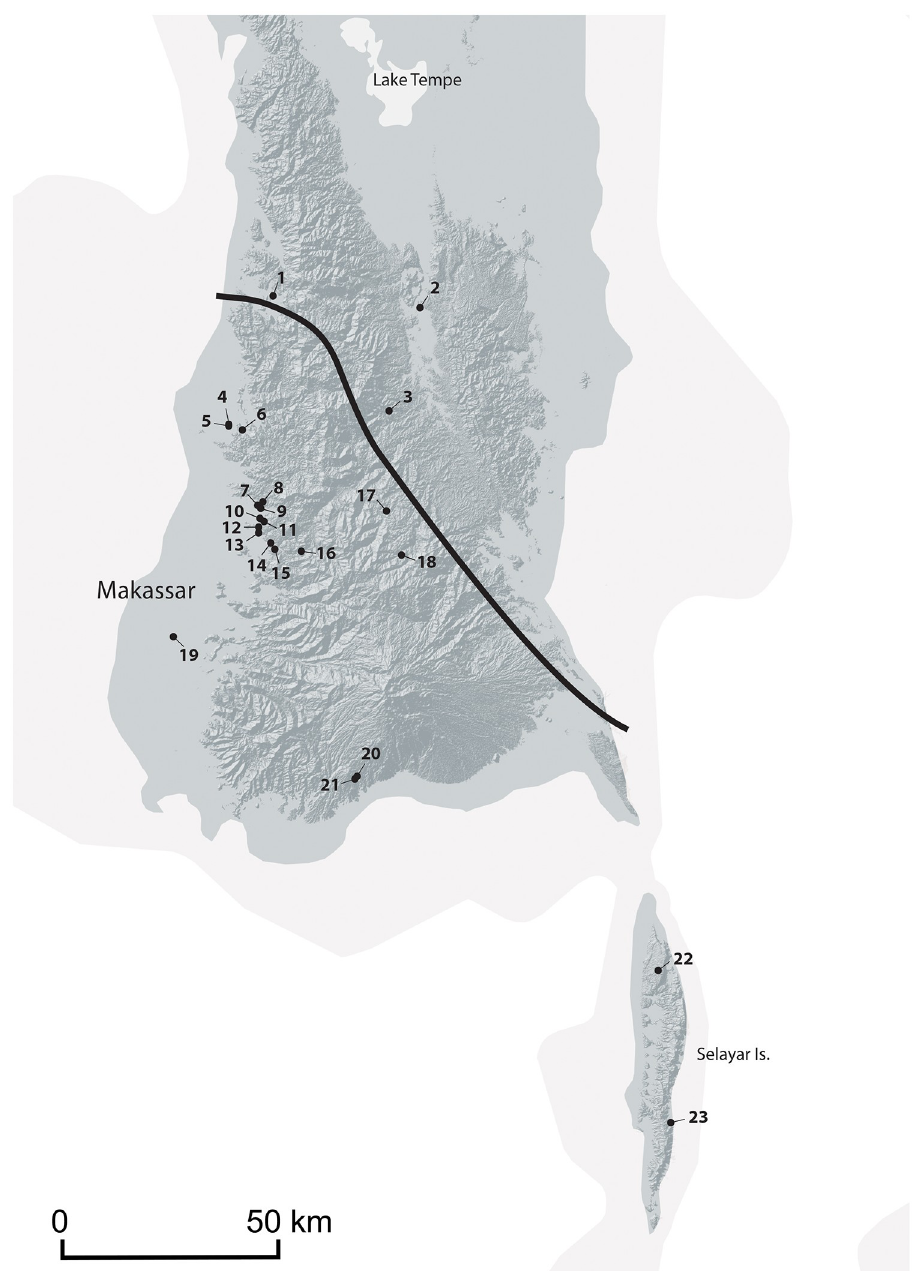
Fig 1. Map of South Sulawesi, Indonesia, showing sites mentioned in the text. 1 . Ralla, 2 . Mallinrung, 3 . Leang Panninge, 4 . Leang Bulu’ Sipong 4, 5 . Leang Bulu’ Sipong 1, 6 . Leang Sakapao, 7 . Leang Rakkoe, 8 . Leang Lompoa, 9 . Leang Lambatorang, 10 . Leang Pajae, 11 . Ulu Leang 1, 12 . Leang Bulu Bettue, 13 . Leang Burung 1 & 2, 14 . Leang Jarie, 15 . Leang Karassa, 16 . Tallasa, 17 . Lamoncong, 18 . Balang Metti, 19 . Pammangkulang Batua, 20 . Pangnganikang, 21 . Batu Ejayya, 22 . Silolo, 23 . Jammeng. Bulbeck’s “Classical Toalean” Line [20], shown in black, marks the known extent of hollow-based denticulated Maros points and backed microliths which he has proposed may represent a ‘southwest’ Toalean entity [e.g. 52]. Recently both artefact types have been recovered from the site on Leang Panninge, just north of this Line [54]. Basemap made with Natural Earth 2009–2020 under CC-O, DEM created from STRM files available from the USGS Earth Explorer, image compiled by Kim Newman and Yinika L